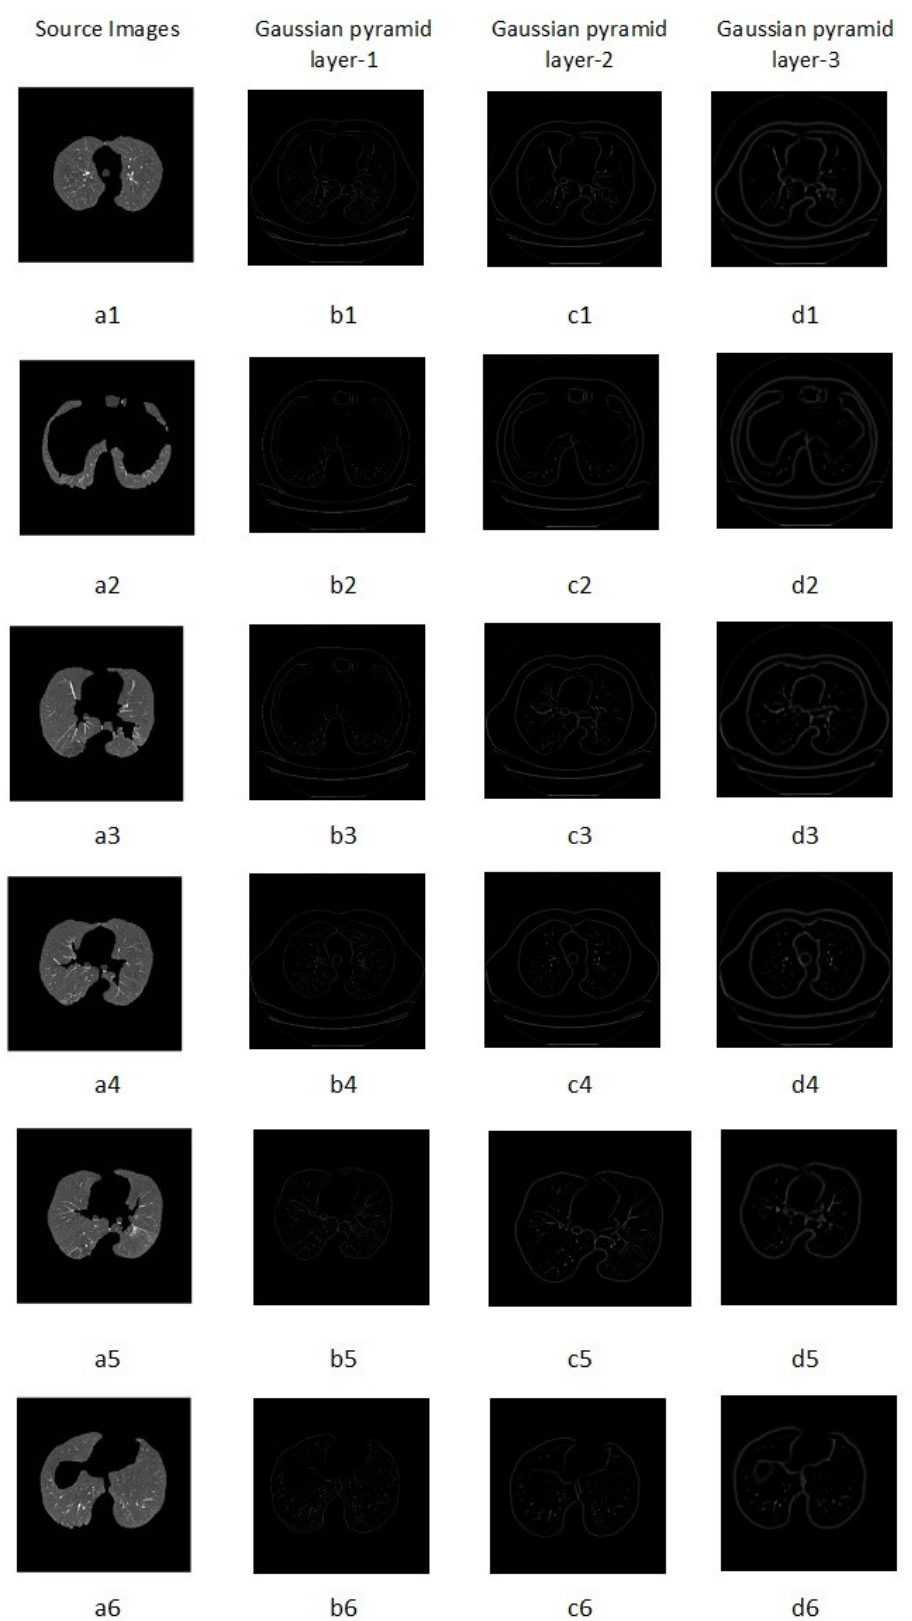
Figure 10. ( a ( 1 – 6 )) Source images; ( b ( 1 – 6 )) Gaussian pyramid of Layer 1; ( c ( 1 – 6 )) Gaussian pyramid of Layer 2; ( d ( 1 – 6 )) Gaussian pyramid of Layer